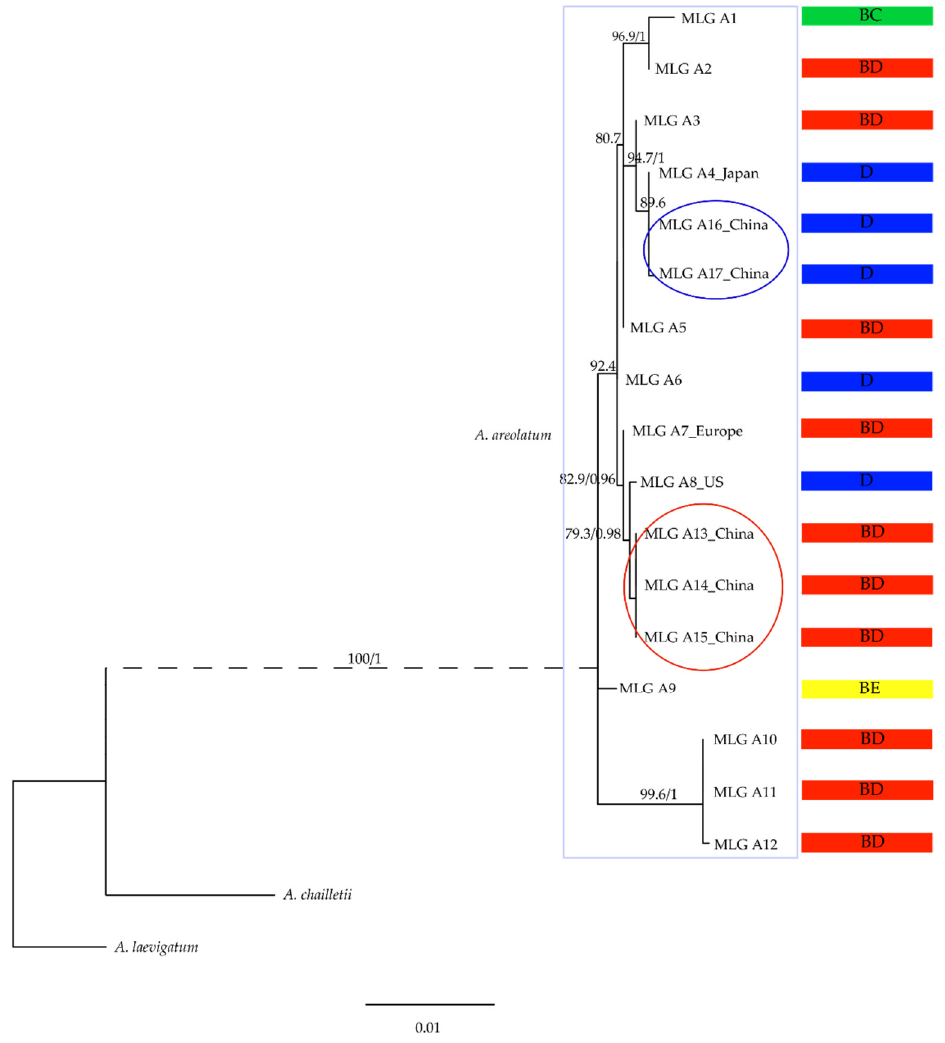
Figure 3. Phylogenetic relationships of Amylostereum spp. Majority-rule consensus tree based on the concatenated ITS, tef1 , RPB2 , and mtSSU genes inferred from maximum likelihood (ML) and Bayesian inference (BI) analyses. ML bootstrap values ( ≥ 70%) and Bayesian posterior probabilities (>0.95) are shown at the nodes. The IGS types are indicated on the right (BC, BD, D, BE). The Chinese strains are circled in red and blue. Clonal lineages with missing data for the tef1 locus were excluded from the